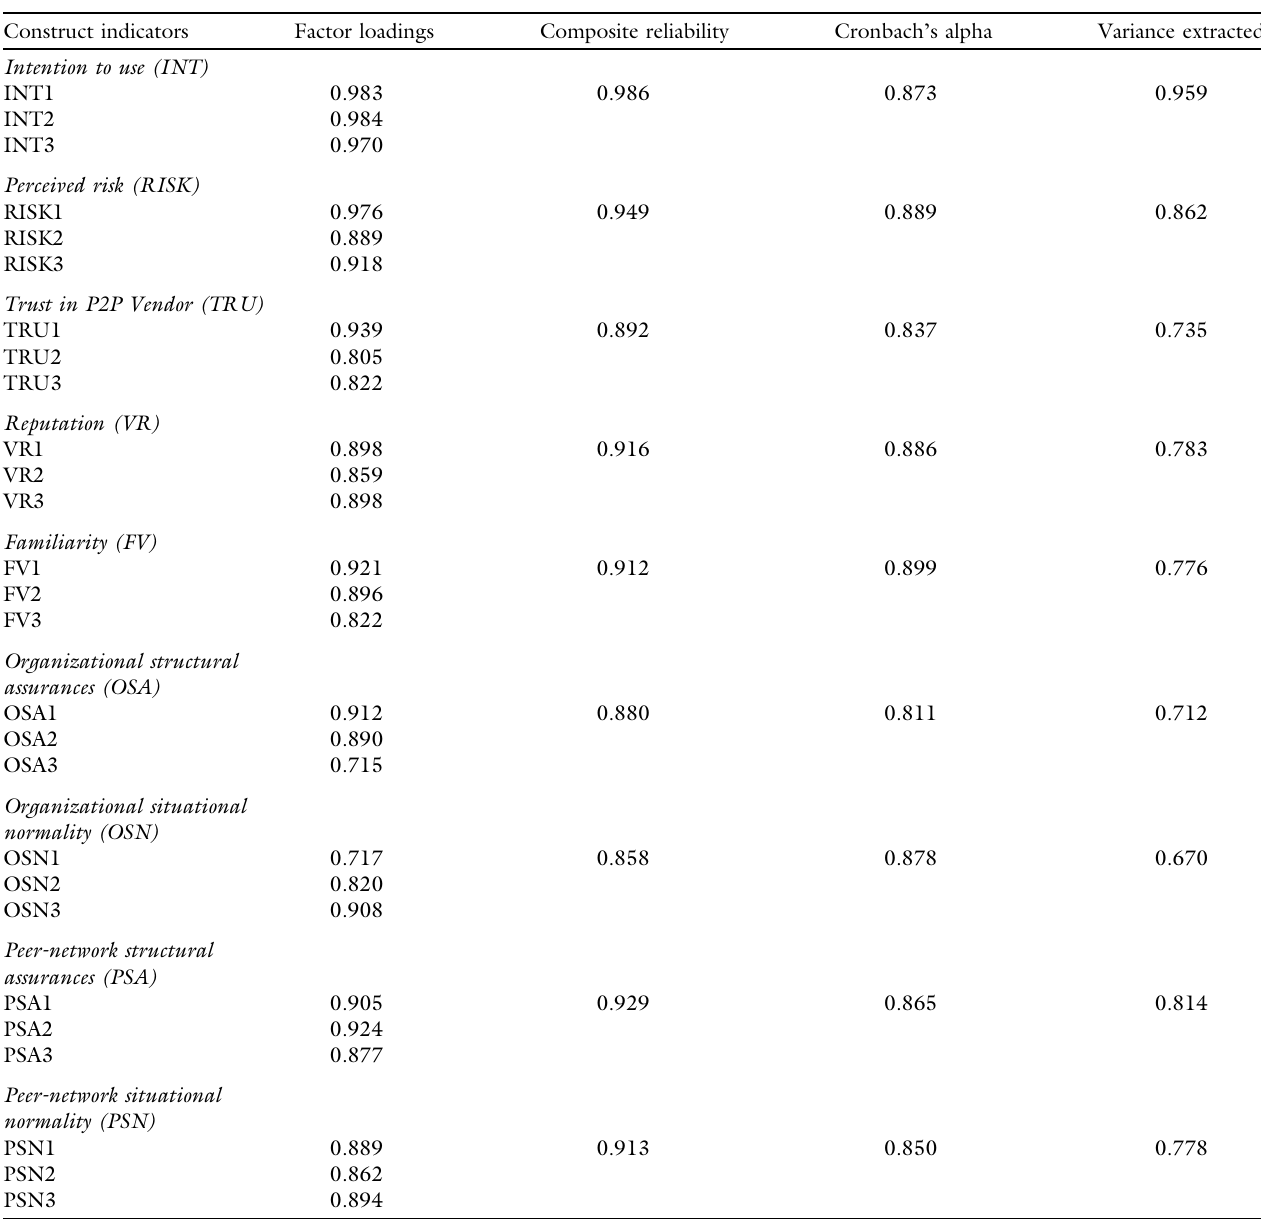
Table 1. Psychometric properties of the measurement model.